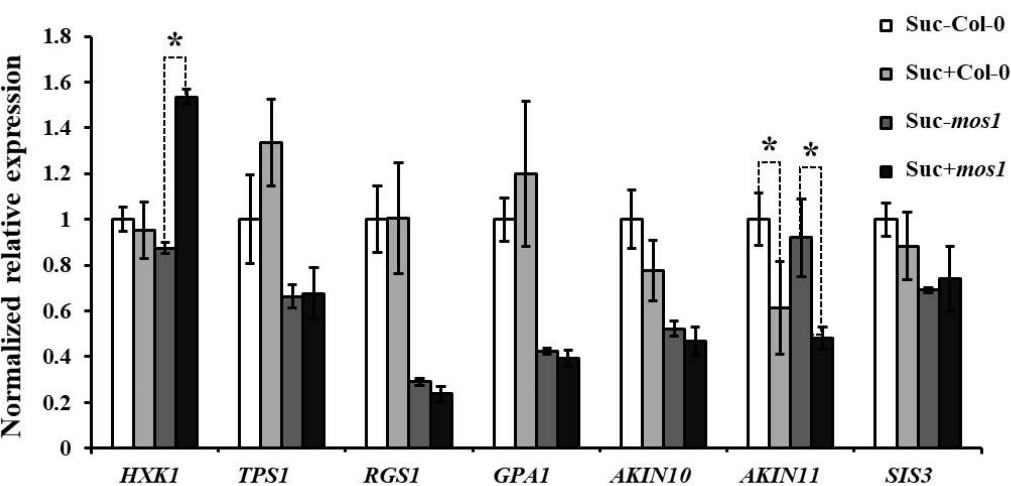
Figure 3. Sugar related gene expression analysis in Col-0 and mos1 . qRT-PCR analysis of the expression of genes involved in sugar-response pathways in Col-0 and mos1 grown on half MS at 3 hours after 6% sucrose (Suc + ) or 6% mannitol (Suc-) treatment. Quantification was normalized to ACTIN2. Error bars indicate SE of two independent biological replicates. The asterisks indicate a significant di ff erence between Suc + and Suc- in each genotype (Student’s t -test p < 0.001).